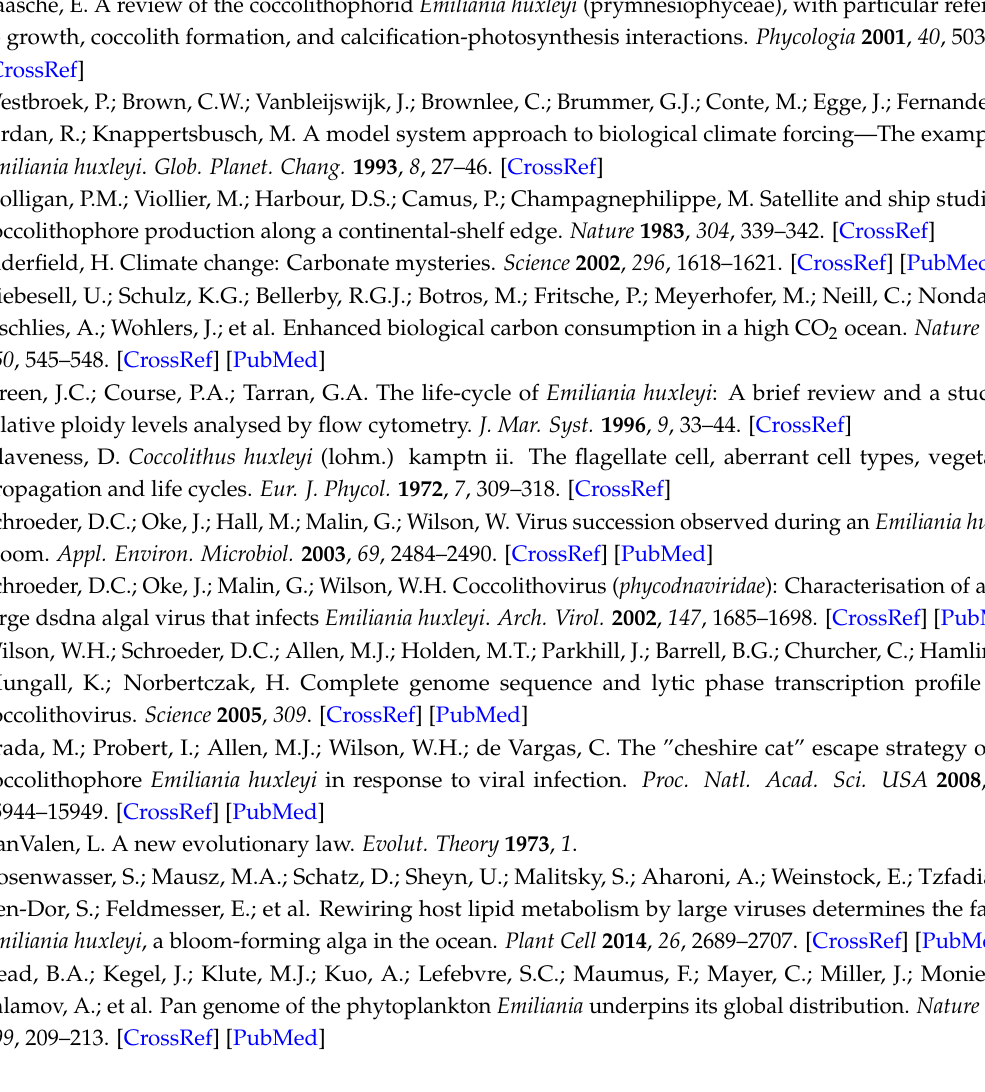
Figure S1: CCMP1516 tiling array, Figure S2: Multiple sequence alignment of PCR-amplified GPA sequence from RCC1217 (1N) compared to previously sequenced GPA amplicons, Figure S3: Pairwise nucleotide sequence alignment of fragments of the amplified RT-PCR products of the dynein heavy chain (DHC) (A,B) inner arm (DHC1b) and (C,D) outer arm (DHCb) genes, Table S1: Unique EhV-86 CDSs expression data, Table S2: Presence of NCLDV Core genes in the EhV-86 genome and in the transcriptome of the virus infecting RCC1217, Table S3: Haploid unique transcripts in the EhV-86 genome and in the transcriptome of the virus infecting